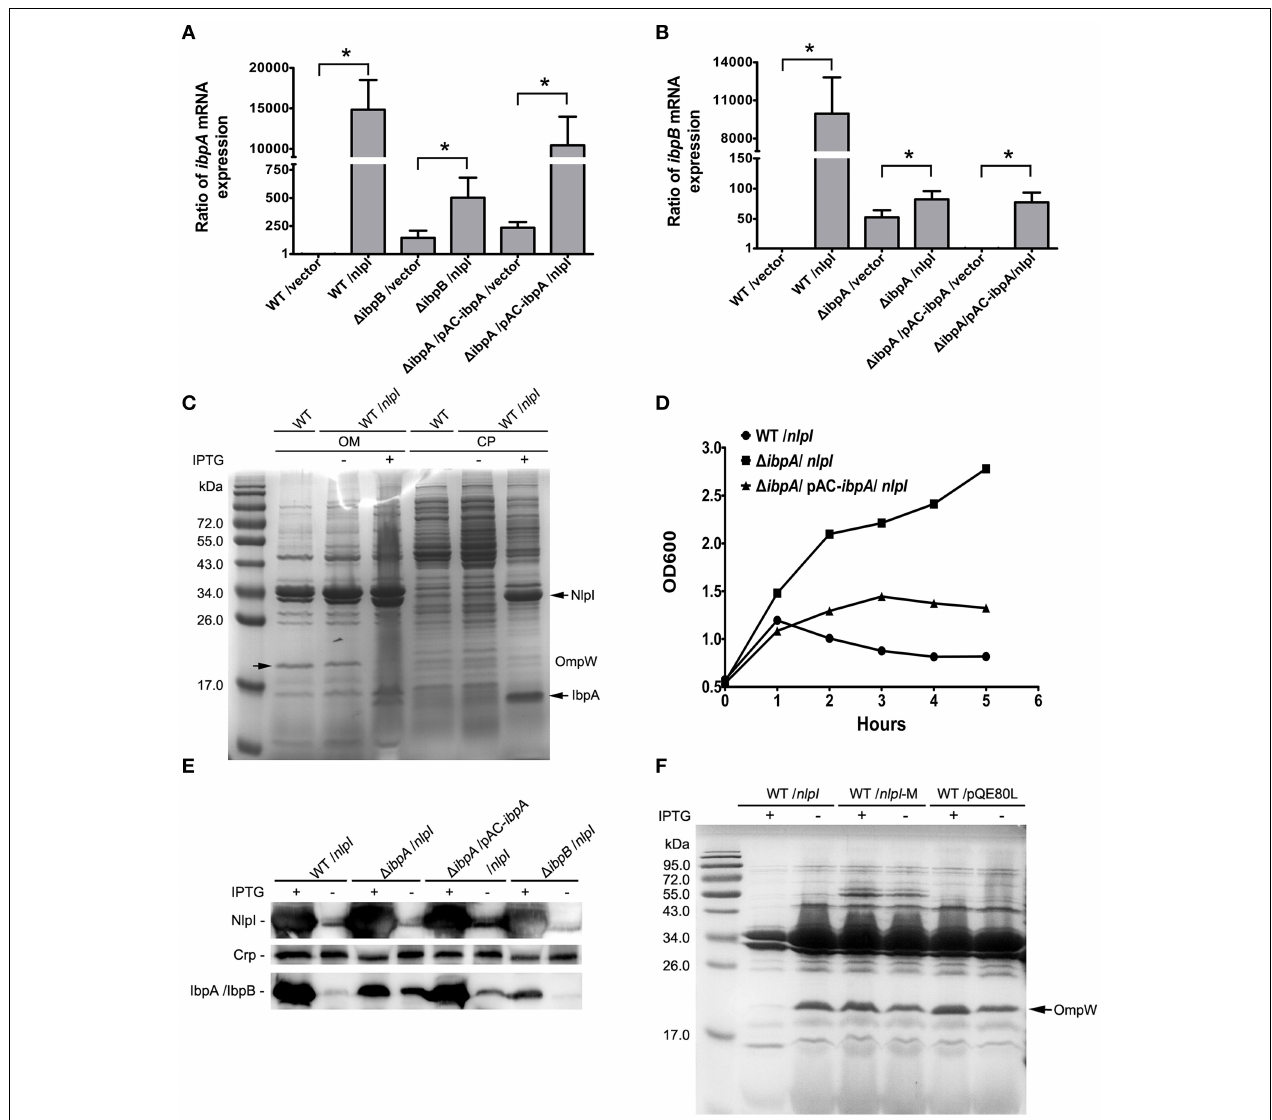
FIGURE 3 | IbpA and IbpB are required for the NlpI-participated cell division. (A) The levels of ibpA mRNA were significantly increased with induction of nlpI in wild type strain or complementation strain. The level of ibpA mRNA in wild type strain with vector was set at one. The levels of ibpA mRNA in MG1655/pQE80- nlpI and (cid:2) ibpB /pQE80- nlpI were increased 14,839.7 ± 3672.3 and 502.2 ± 178.8 fold, respectively, compared with control. The level of ibpA mRNA in (cid:2) ibpA /pAC- ibpA /pQE80- nlpI was increased by 10,437.3 ± 3536.5 fold. The error bars indicated the SD representing the means from three independent experiments. (B) The levels of ibpB mRNA were the remarkably increased with over-expression of nlpI in wild type strain. The level of ibpB mRNA of wild type strain with empty vector was set at 1. The levels of ibpB mRNA of wild type strain and (cid:2) ibpA with